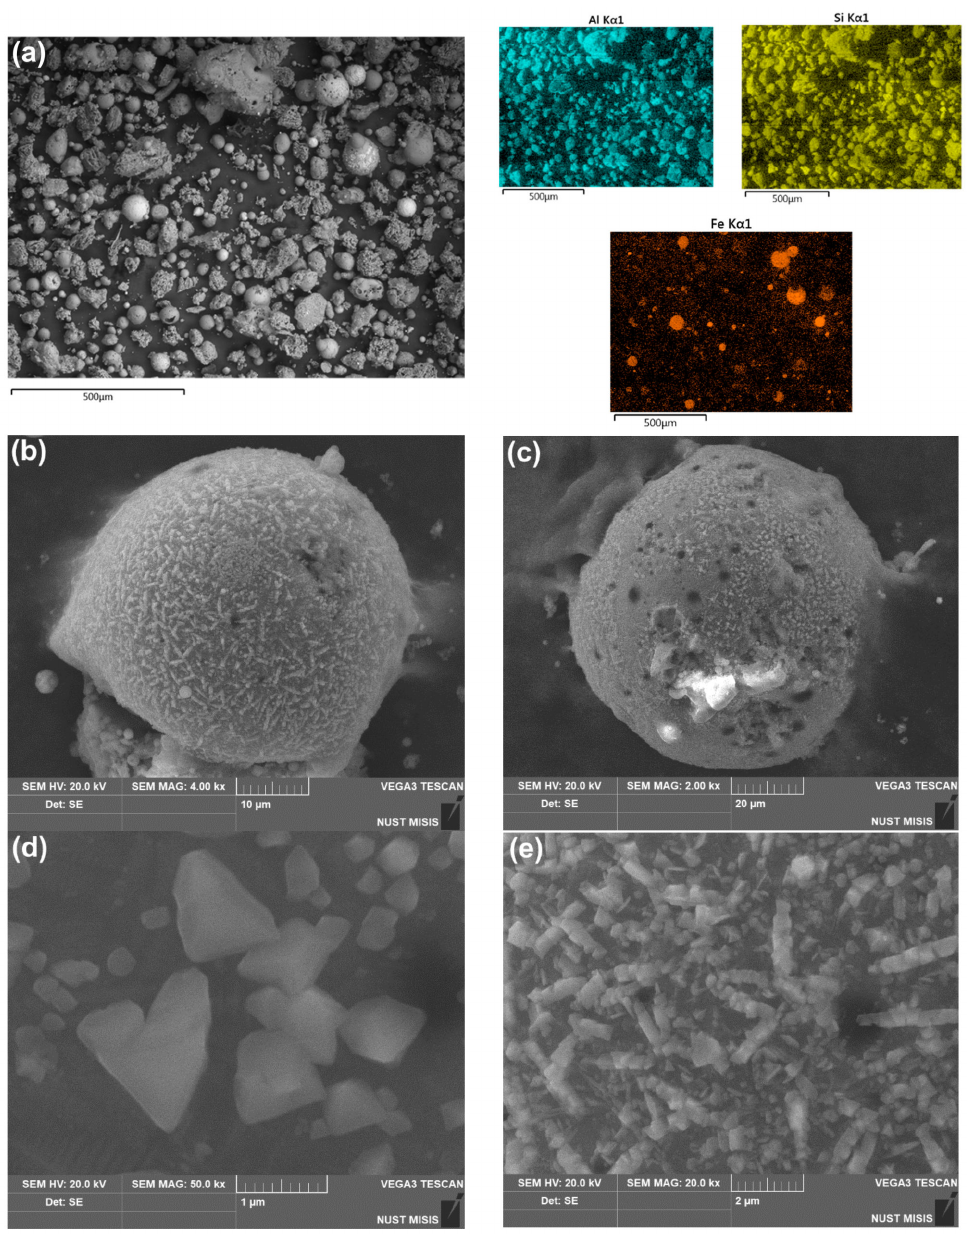
Figure 2. SEM images of the CFA samples: ( a ) particles of feed ash (the mapping shows distribution of aluminum, silicon and iron), ( b , c ) spherical particles with magnetite on the surface, ( d ) individual octahedral crystals of magnetite, ( e ) stick shaped agglomerates of